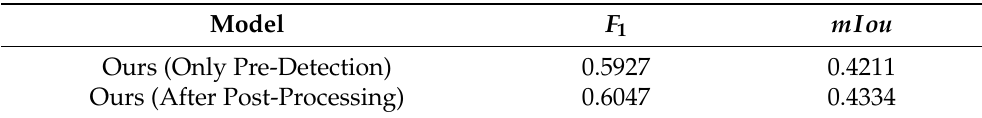
Table 2. Quantitative results of Post-Processing.The Point-level F 1 score ( PF 1 ) and the mean IoU ( mIoU ) are reported.